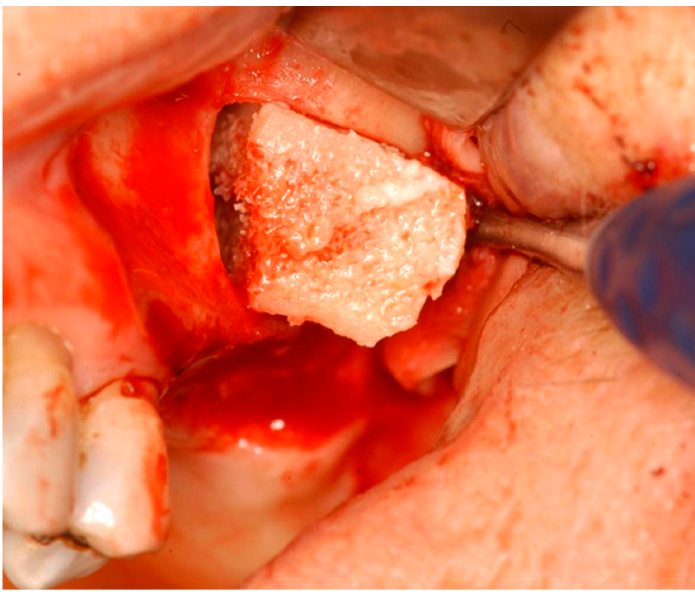
Figure 1. A monocortical-cancellous block of fresh frozen allogeneic bone from the iliac crest (FFB) was inserted into the sinus cavity after opening a lateral window and carefully detaching the Schneiderian membrane.